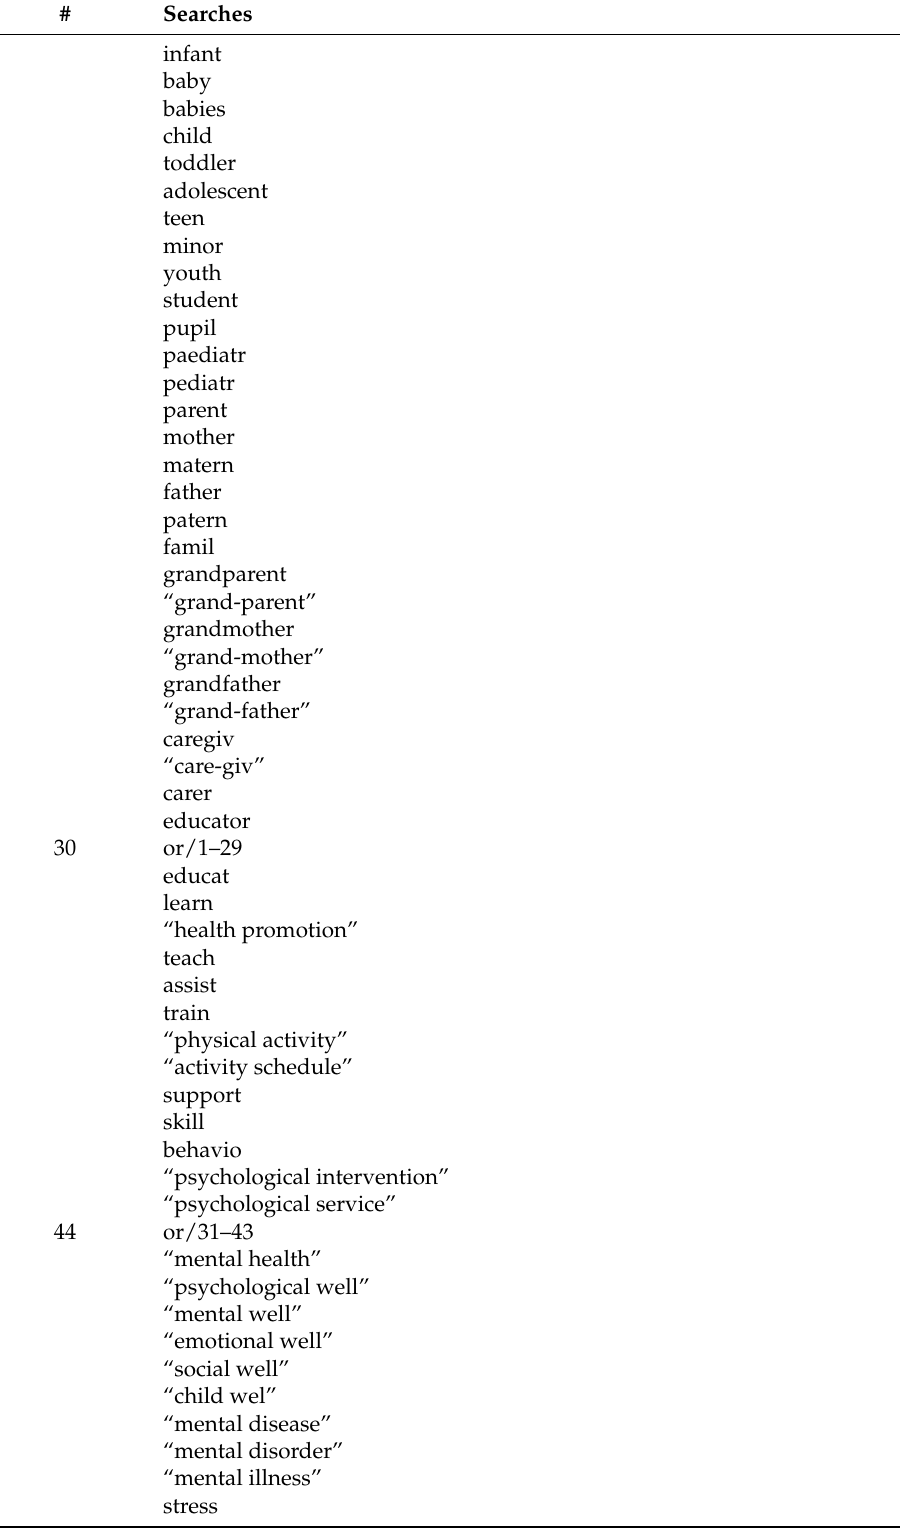
Table A4. Search